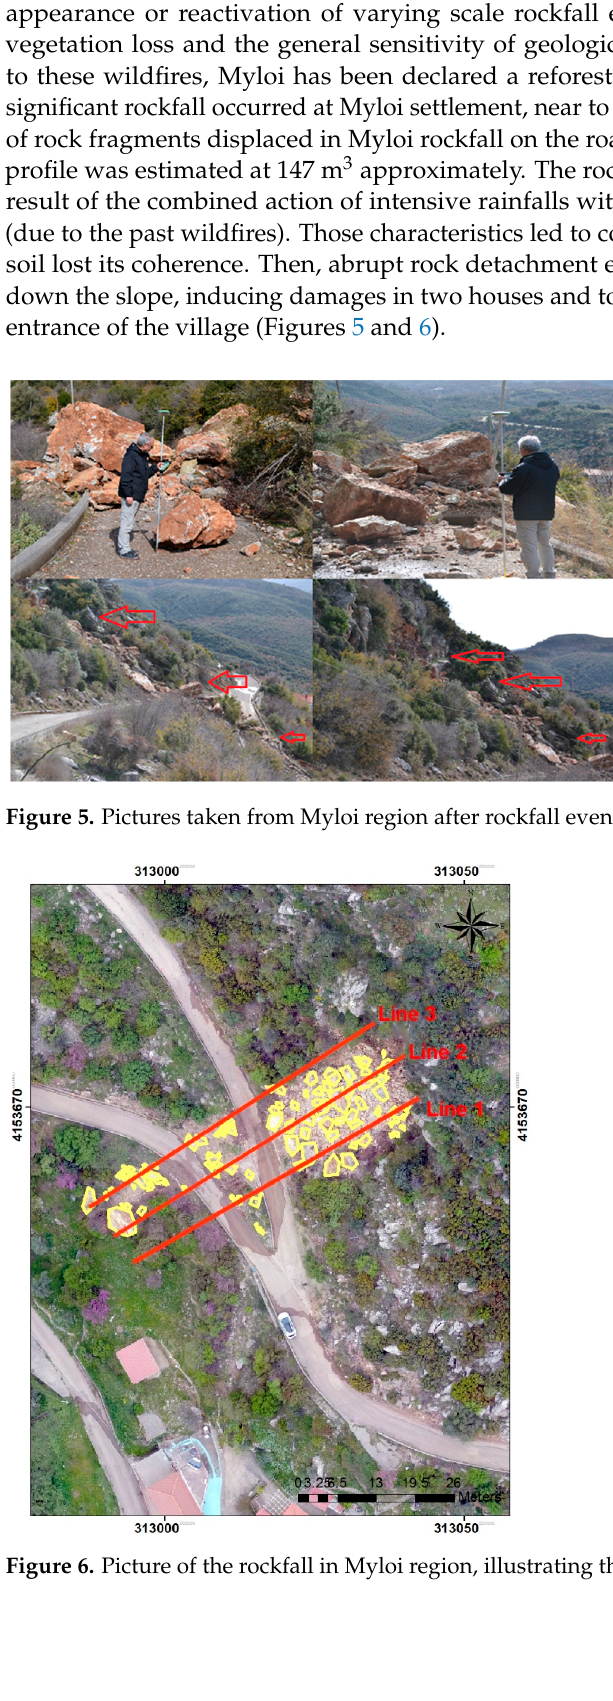
Figure 4. Slope profiles used in RocFall analysis regarding Myloi region. The slope picture is taken from Greek Cadastral (2008). Table 3. Geological and material characteristics.